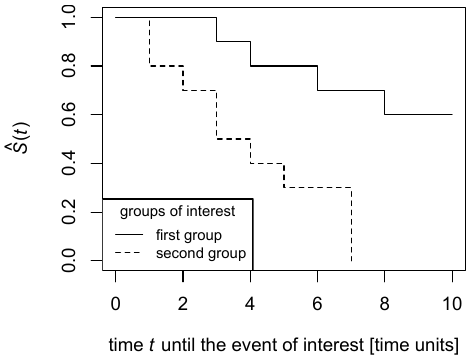
Figure 2. An example of two random survival curves; the first one is leveling off while the second one is dropping to